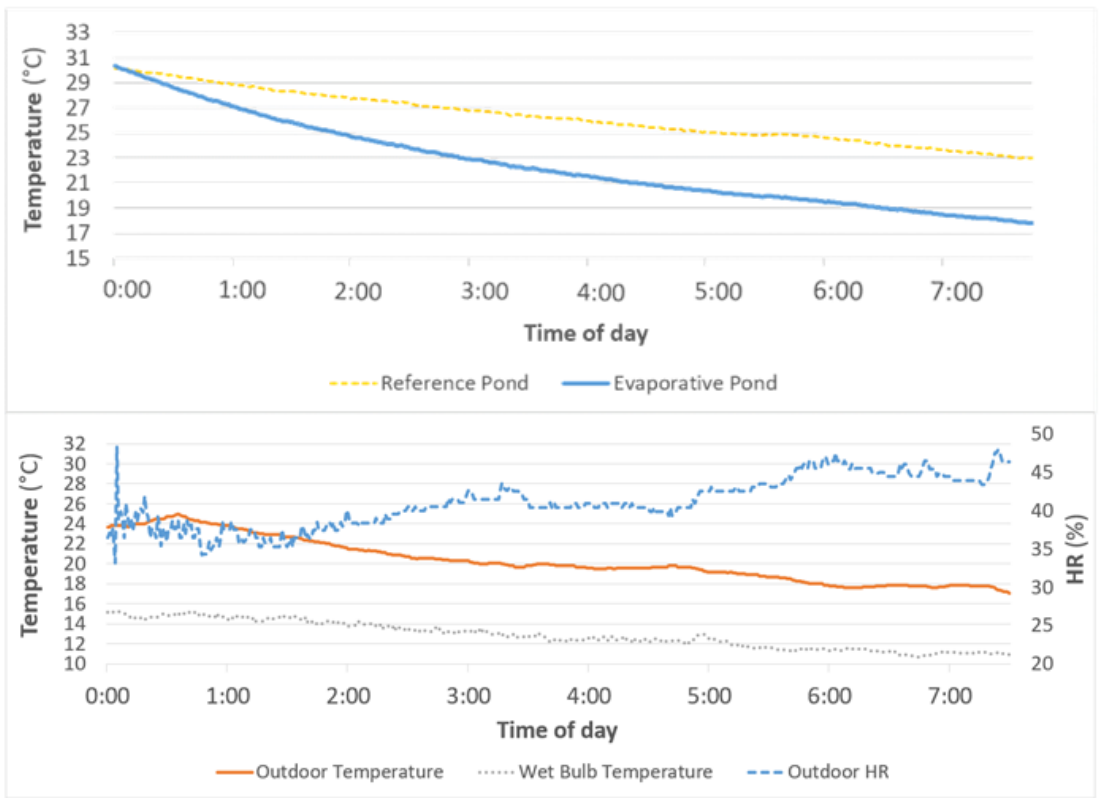
Figure 8. Water temperature fluctuations in the reference pond and the evaporative pond with HARDI ISO F-110-04 nozzles ( up ) and environmental conditions: dry-bulb temperature, wet-bulb temperature, and humidity ratio HR ( down ).